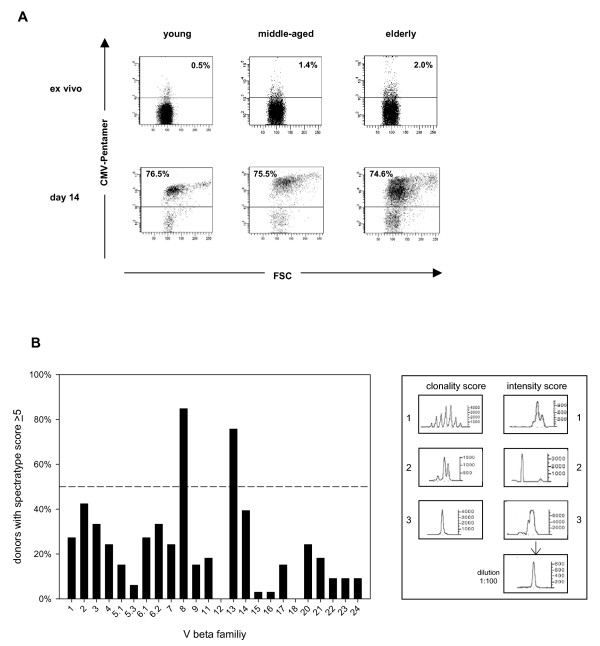
Preferential expansion of BV8 and BV13 CD8+ T cells after stimulation with CMVNLV-peptide. Cells were stimulated in vitro for 14 days with CMVNLV-peptide in the presence of IL-2 and autologous, irradiated PBMC. (A) CD8+ T cells were stained with APC-conjugated pentamers containing the CMVNLV-peptide. Representative examples are shown for one young, one middle-aged and one elderly donor directly ex vivo and after 14 days of culture. Percentages of CD8+ CMVNLV-specific T cells are indicated. (B) After 14 days of culture CMVNLV-specific T cells were further purified from the expanded cells using MACS-technology. Spectratyping was performed from PCR-products of 24 individual V beta families for 31 donors (10 young, 7 middle-aged, 14 elderly). In the right panel examples for the different clonality and intensity scores (see Methods) are shown. Clonality and intensity scores are added to obtain a total score. For each BV family the percentage of donors with a total score above 5 is shown.